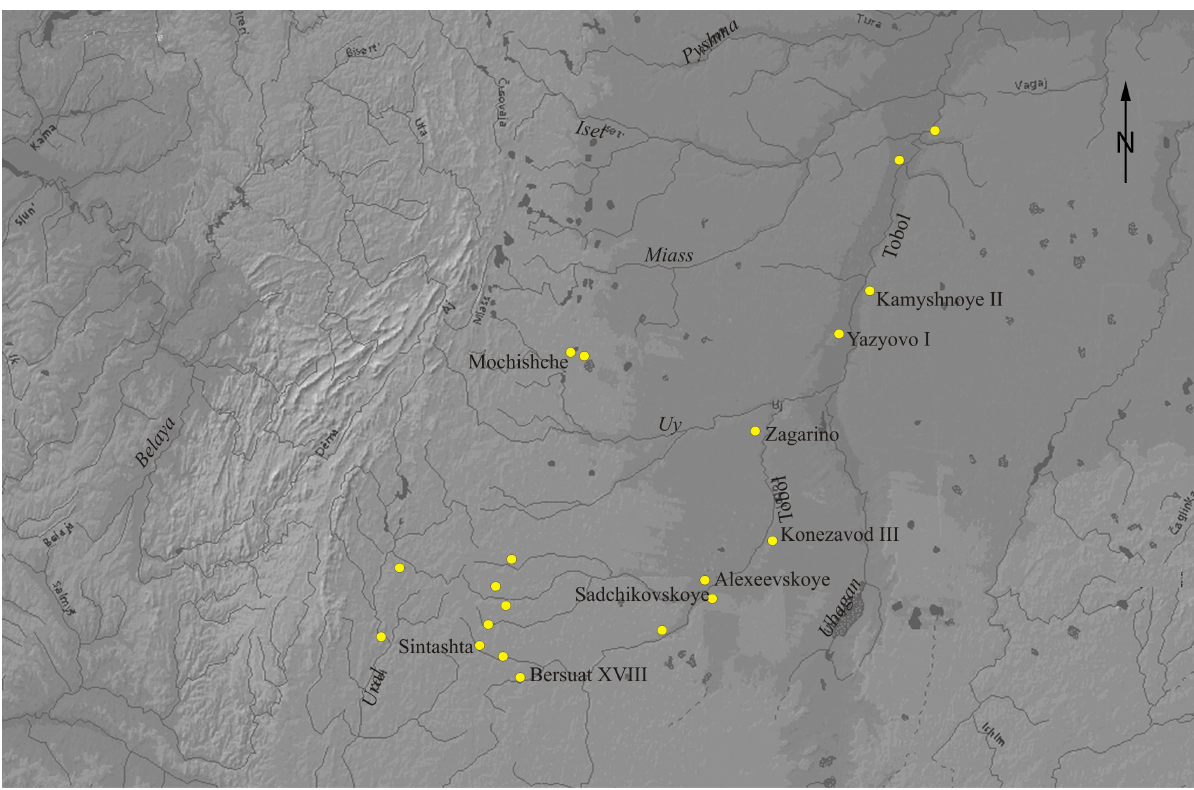
Figure 24: Map of the distribution of Sargari sites in the Southern Transurals. The border between the steppe and forest-steppe is along the Uy River (after Grigoriev,